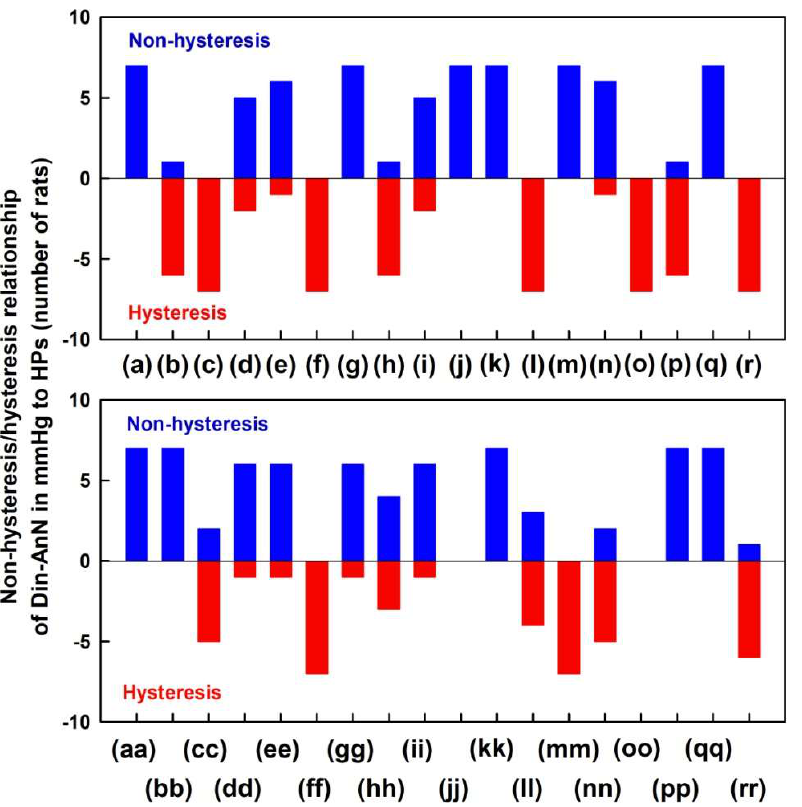
Figure 4. Non-hysteresis / hysteresis patterns of the two-dimensional relationships of HPs to pressure differences of DiN-AnN in mmHg. Data were taken from Figures 3 and S2 (red and blue lines, which represent the time interval of decrease and increase of BP after administration of 32 nmol kg –1 GSNO). Number of rats in which non-hysteresis (blue) or hysteresis (red) patterns were observed ( n = 7). The hysteresis was arbitrarily defined as HPs-(DiN-AnN in mmHg) loop > 5 mmHg of DiN-AnN (in mmHg).